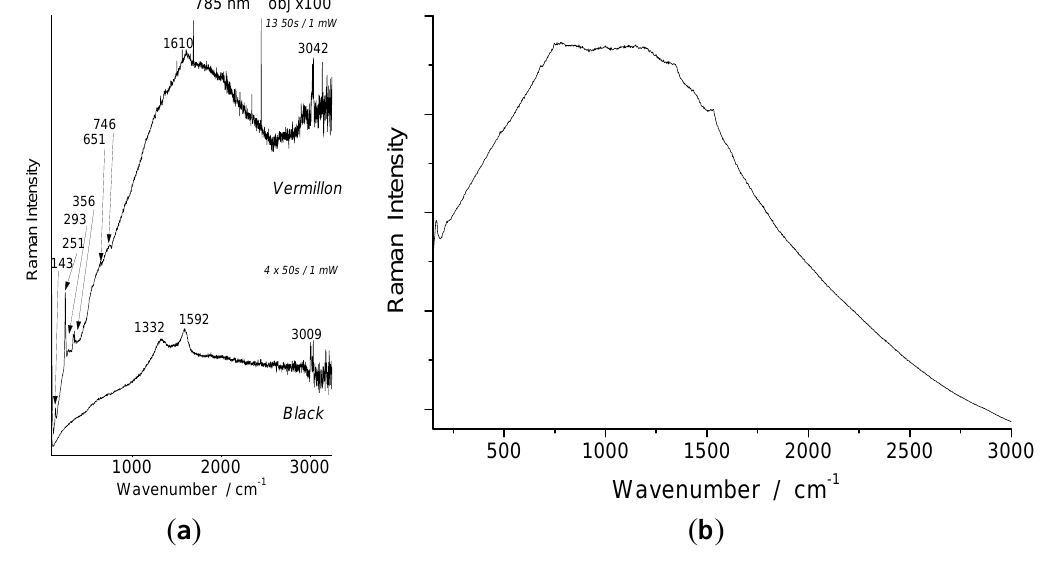
Figure 7. ( a ) Representative Raman signatures recorded with 785 nm excitation at red and black spots (see Figure 1) on Kim’s portrait. ( b ) Representative raw Raman signature recorded with 785 nm mobile Raman set-up at blue area of the Flowers’ lacquerware (Figure 2a).